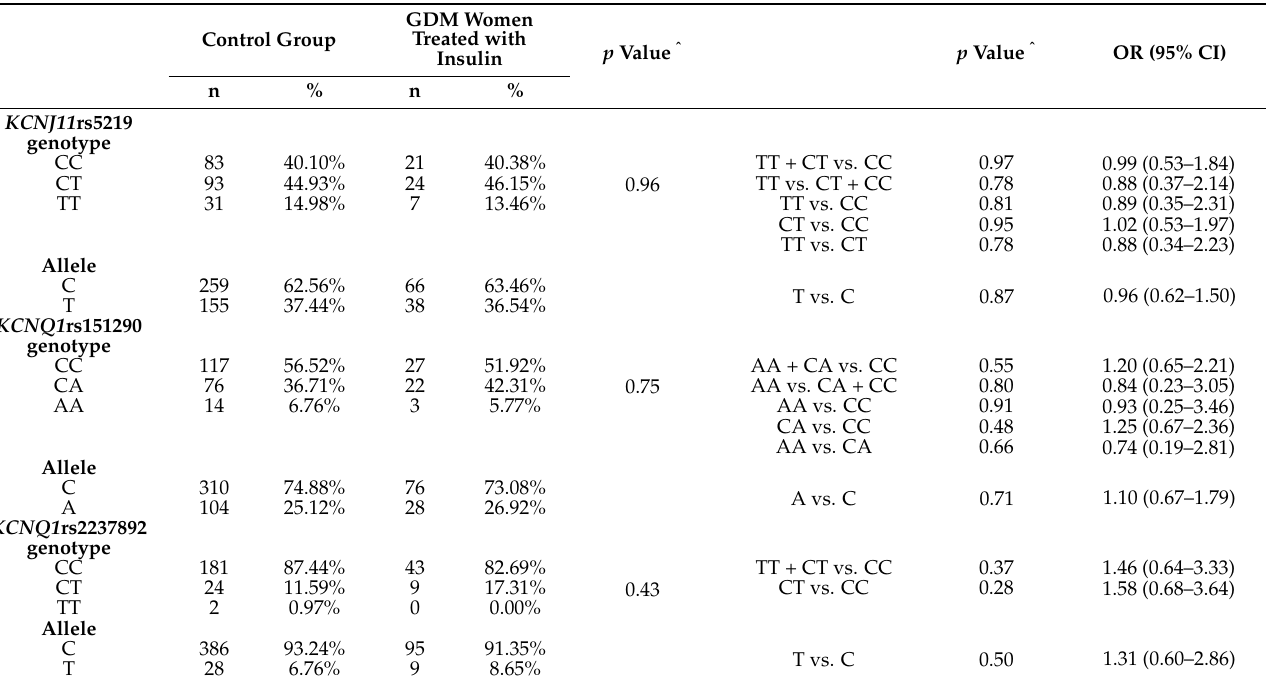
Table 2. Distribution of KCNJ11 and KCNQ1 genotypes in GDM women treated with insulin and control